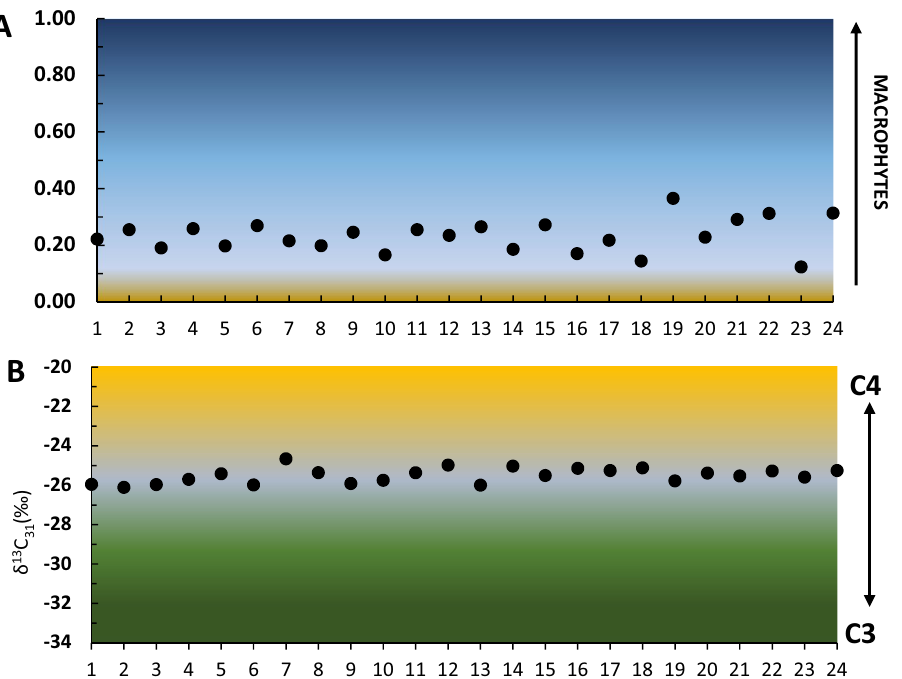
Figure 3. Molecular and isotopic indicators used for vegetation reconstruction at AGS. ( A ) Macrophyte- derived lipids (nC 23 + nC 25 ) relative to macrophytic and terrestrial lipids (nC 23 + nC 25 + nC 29 + nC 31 ). Values of < 0.4 indicate no macrophytes; values of 0.4–1 indicate emergent macrophytes; values > 1 indicate floating macrophytes 19 . Colouring gradient denotes relative macrophyte input. ( B ) Plant-lipid δ 13 C 31 , in which higher values indicate more C4 vegetation